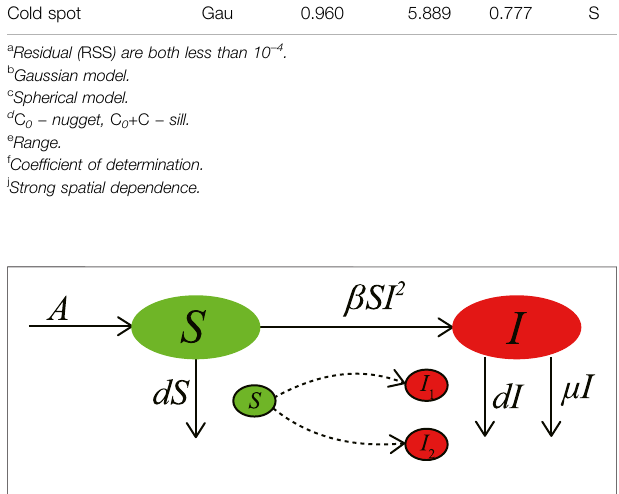
FIGURE 4 | Schematic diagram of infectious diseases transmission process. The model satis fi es the following conditions: 1) the epidemic cannot be cured after being infected; 2) the susceptible is exposed to the disease repeatedly, leading to a non-linear transmission rate.